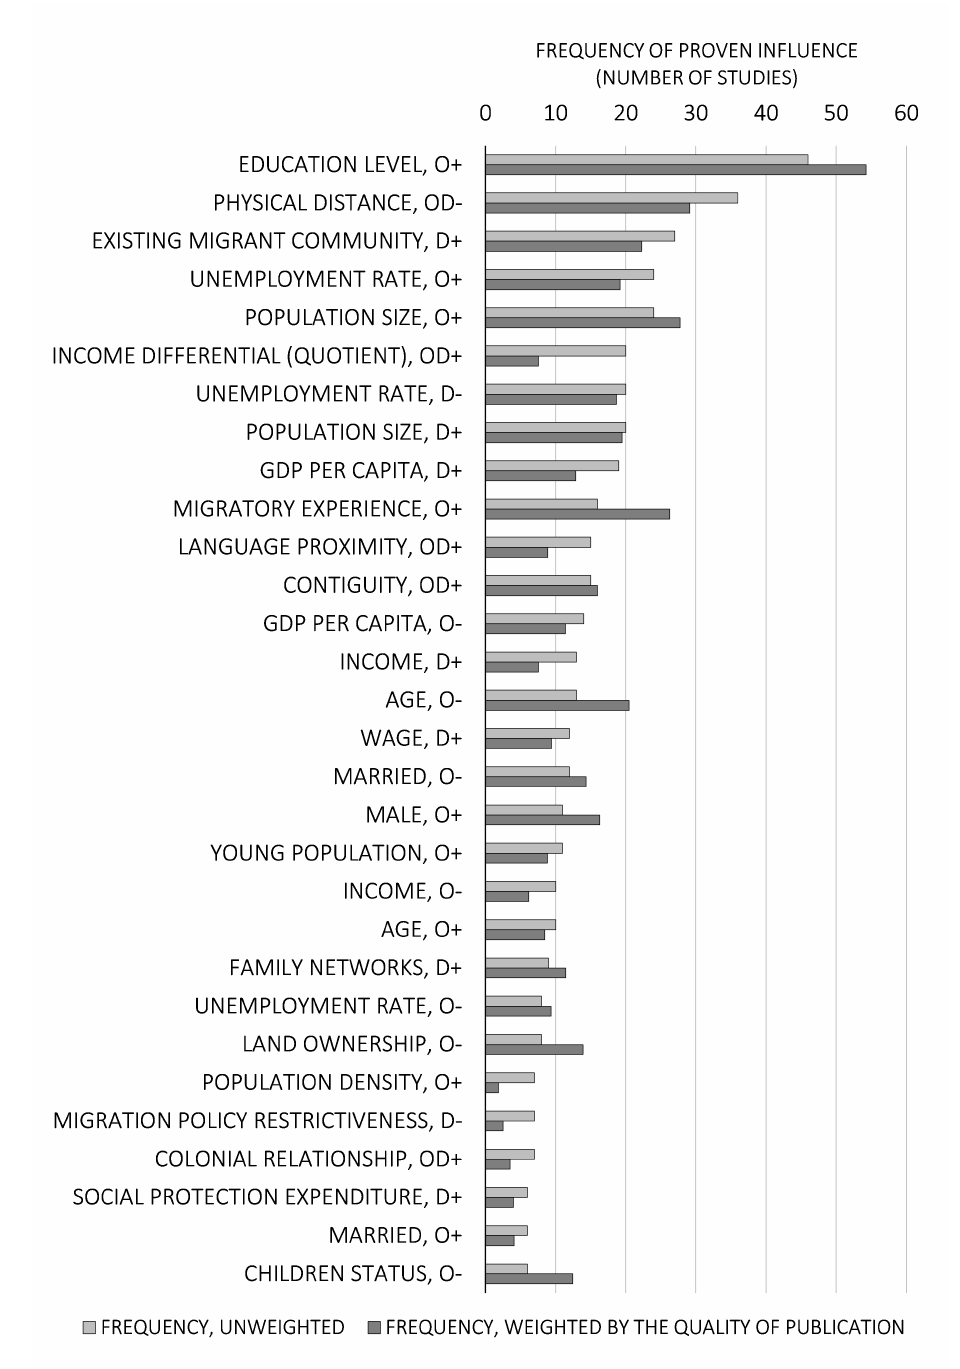
Figure 3. Top factor-migration relationships (aggregated for the studied